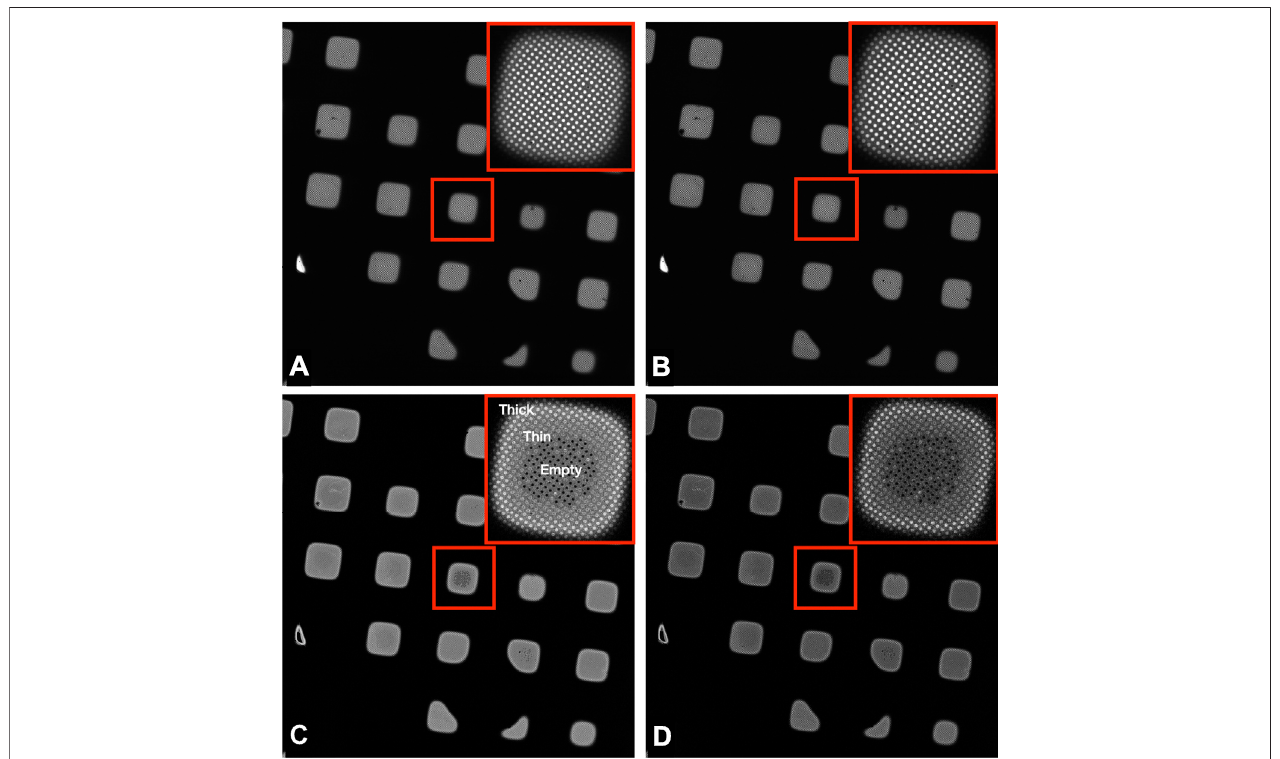
FIGURE 2 | Images of a Quantifoil UltrAuFoil 1.2/1.3 grid, acquired on a Thermo Scienti fi c Titan Krios G1with Gatan Bioquantum K2 detector using EFTEM LM mode×135magni fi cation( fi eldofview×418433 μ m),1-sexposure,totaldose0.001e/Å 2 .Theupperrightcornersshowamagni fi edinsetofthemarkedcentralsquare. Image contrast/brightness has not been changed manually. (A) Un fi ltered image, (B) Zero loss fi ltered linear mode image, (C) plasmon counting mode image, and (D) plasmon counting mode image with 40 μ m SA aperture